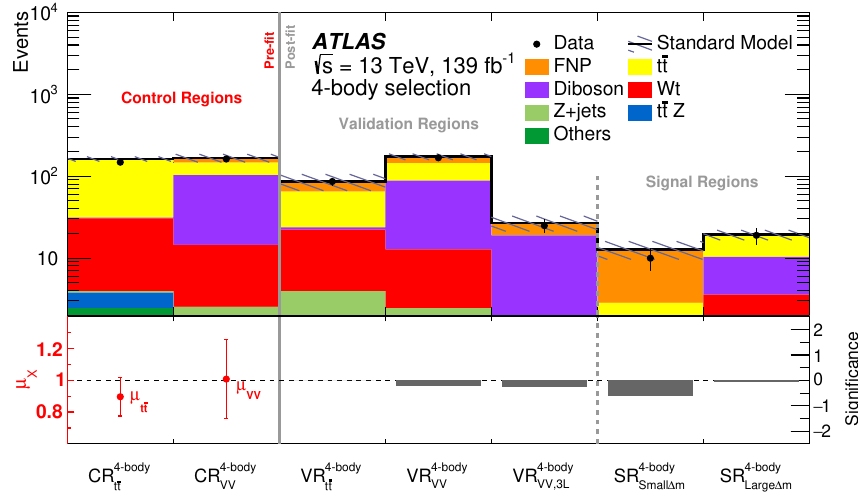
Figure 10 . Four-body selection. Expected and observed yields are shown. The upper panel shows the observed number of events in each of the CRs, VRs and SRs defined in the four-body selection, together with the expected SM backgrounds obtained before the fit in the CRs and after the fit in the VRs and SRs. “Others” includes contributions from V V V , tt t , tttt , tt W , tt WW , tt WZ , tt H , and tZ processes. The shaded band represents the total uncertainty in the expected SM background. The lower panel shows the normalisation factors µ (left two bins) extracted in the X CRs for the tt and diboson processes, while, for the VRs and the SRs (right bins), the significance as defined in ref.